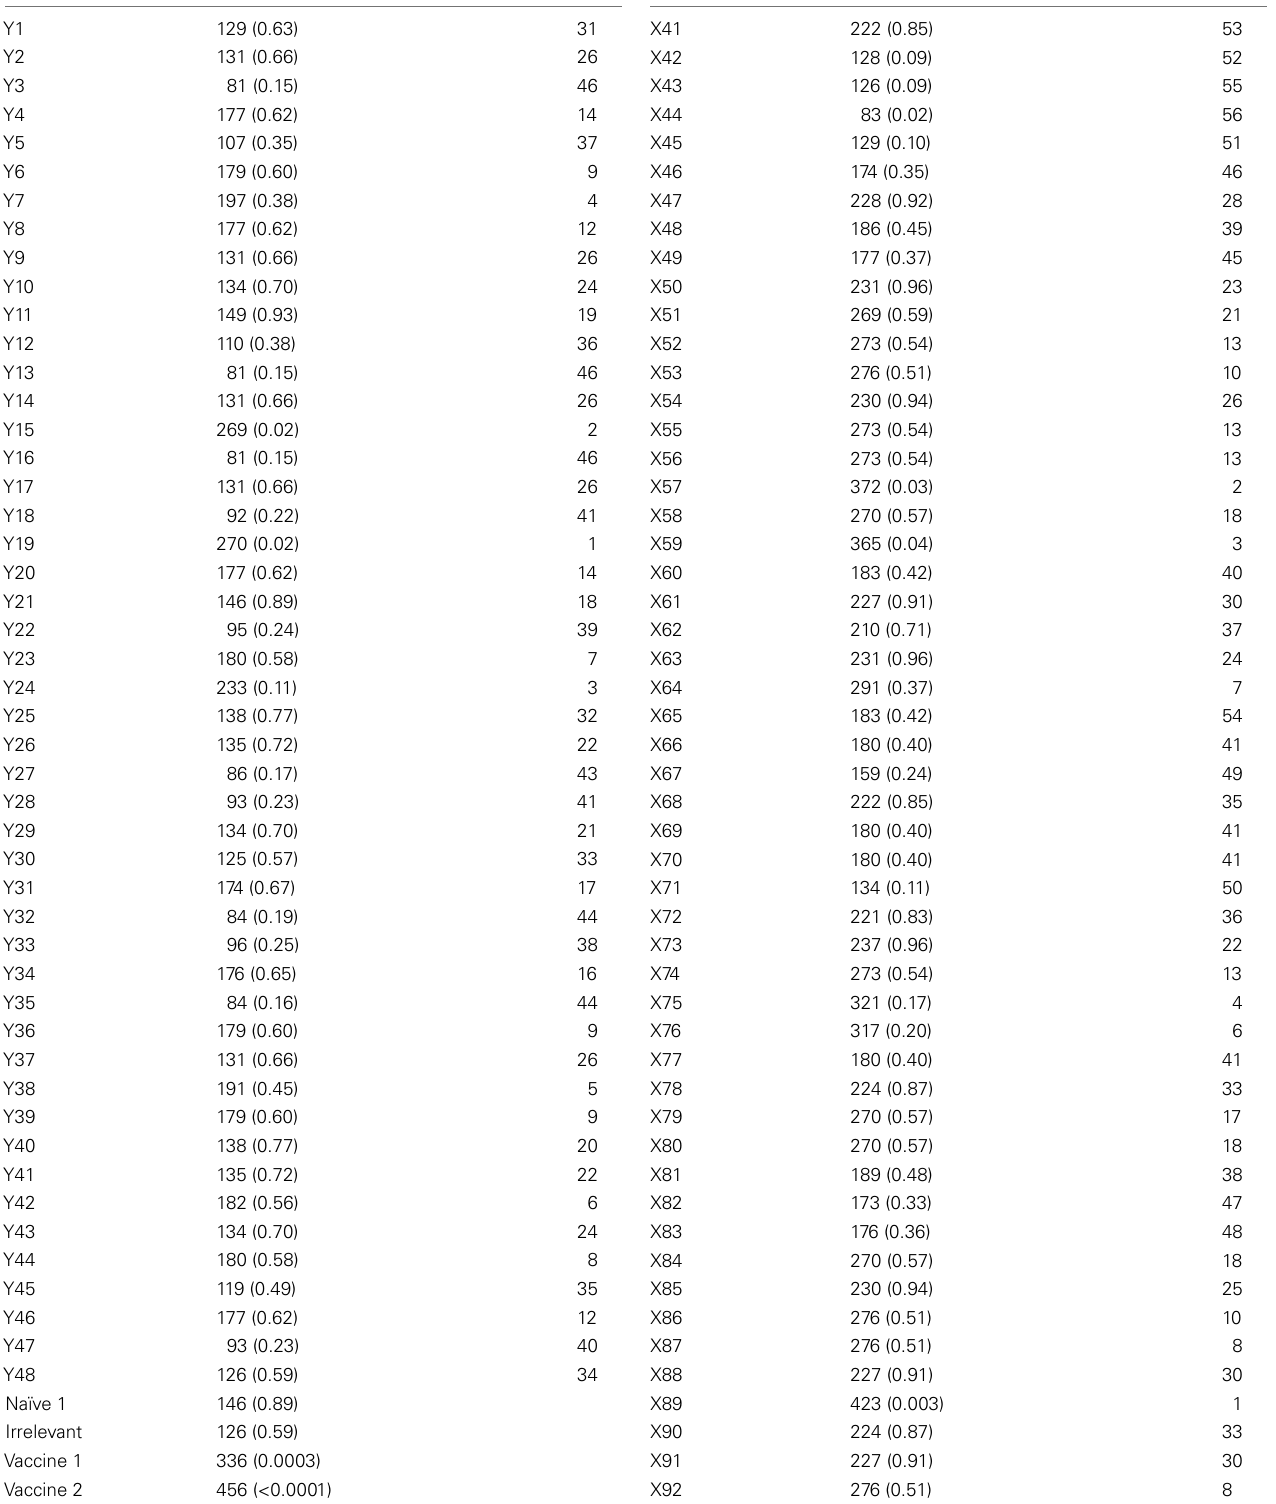
TableA1 | Challenge protection results from ELI